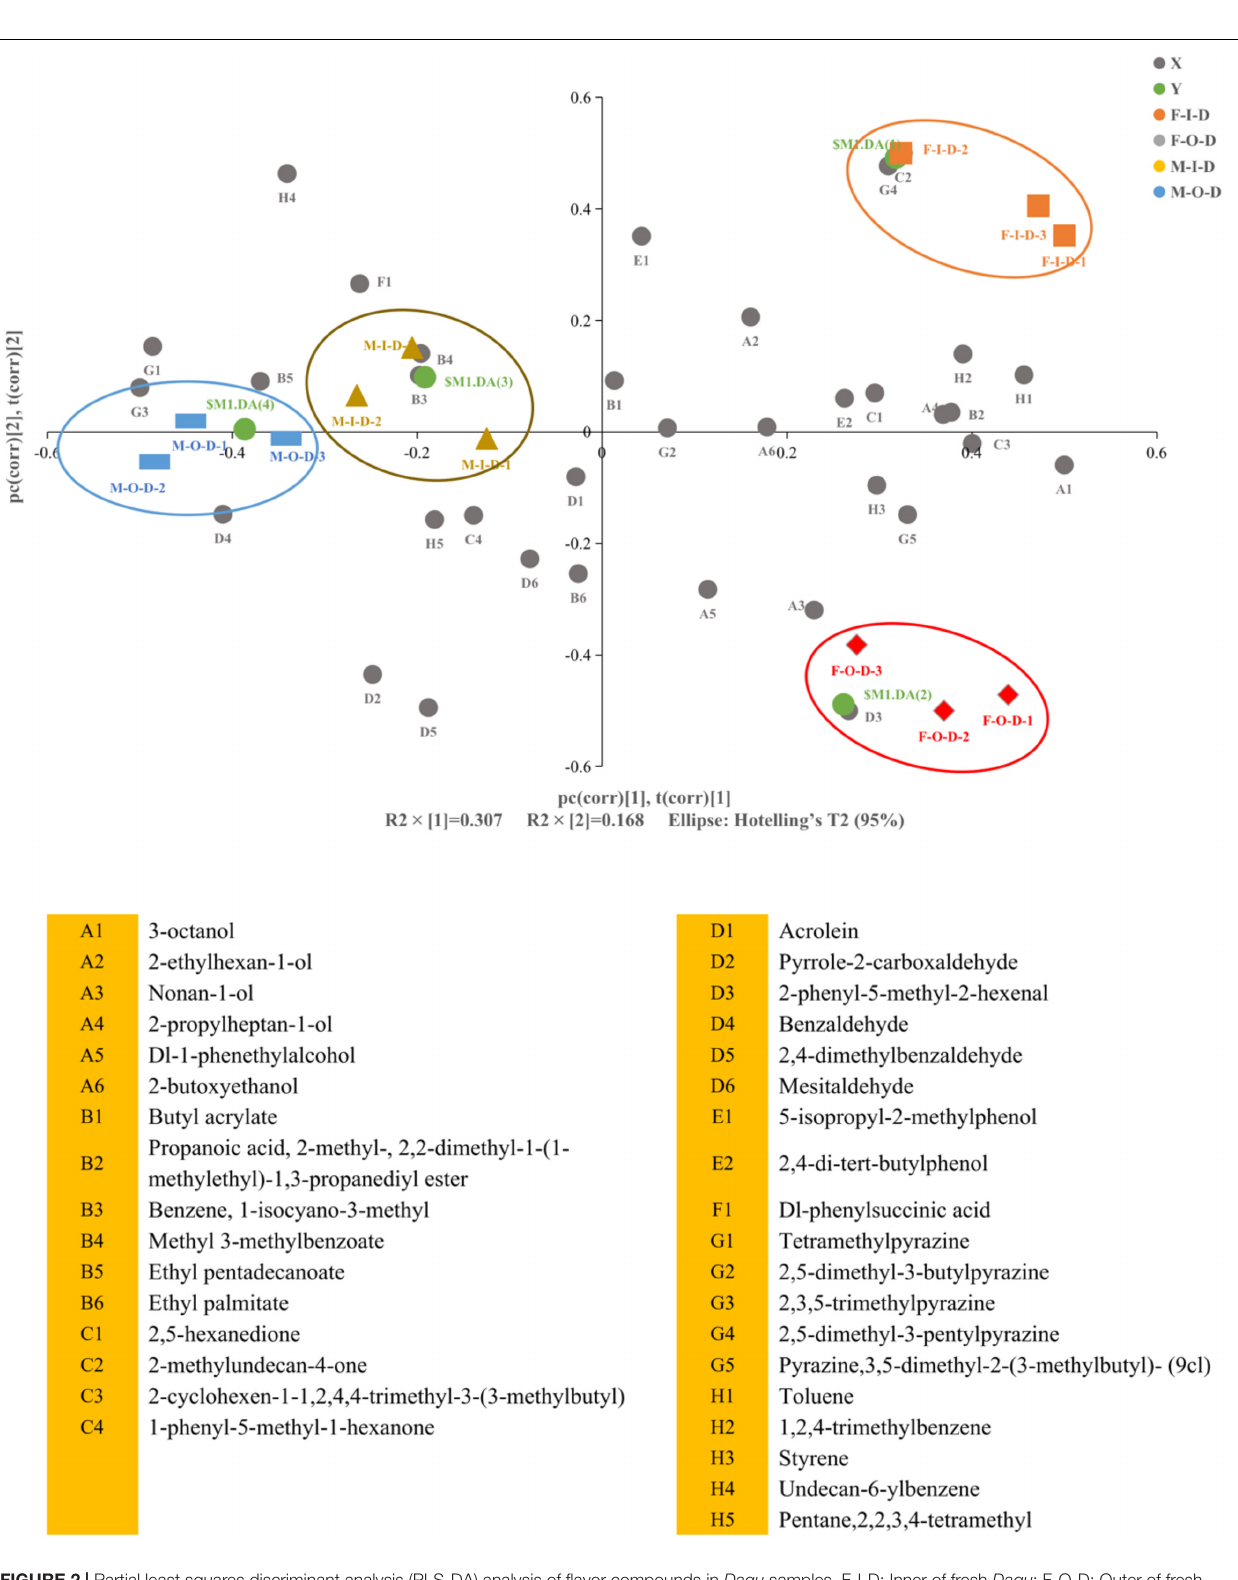
Frontiers in Microbiology |